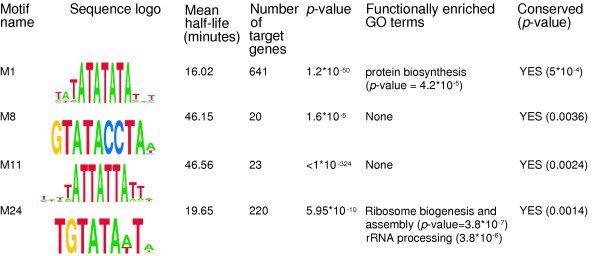
Examples of four of the 53 stability motifs discovered. M1 and M24 are destabilizing motifs, and M8 and M11 are stabilizing. Presented are mean half-life for each motif, and the p-value on the hypothesis that they mediate a significant increase or decrease in half-life compared with the genome, resulting from a ranksum test. Functional enrichment was tested as in Tavazoie et al. [5], hypergeometric p-values, and then applying FDR at q-value = 0.1. 'None' indicates that no GO term passed FDR.